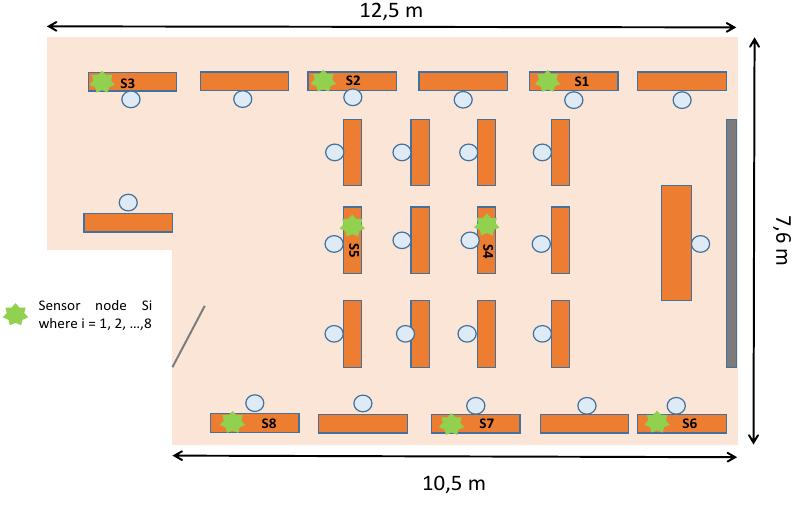
Figure 7. Used configuration for real experimentations.